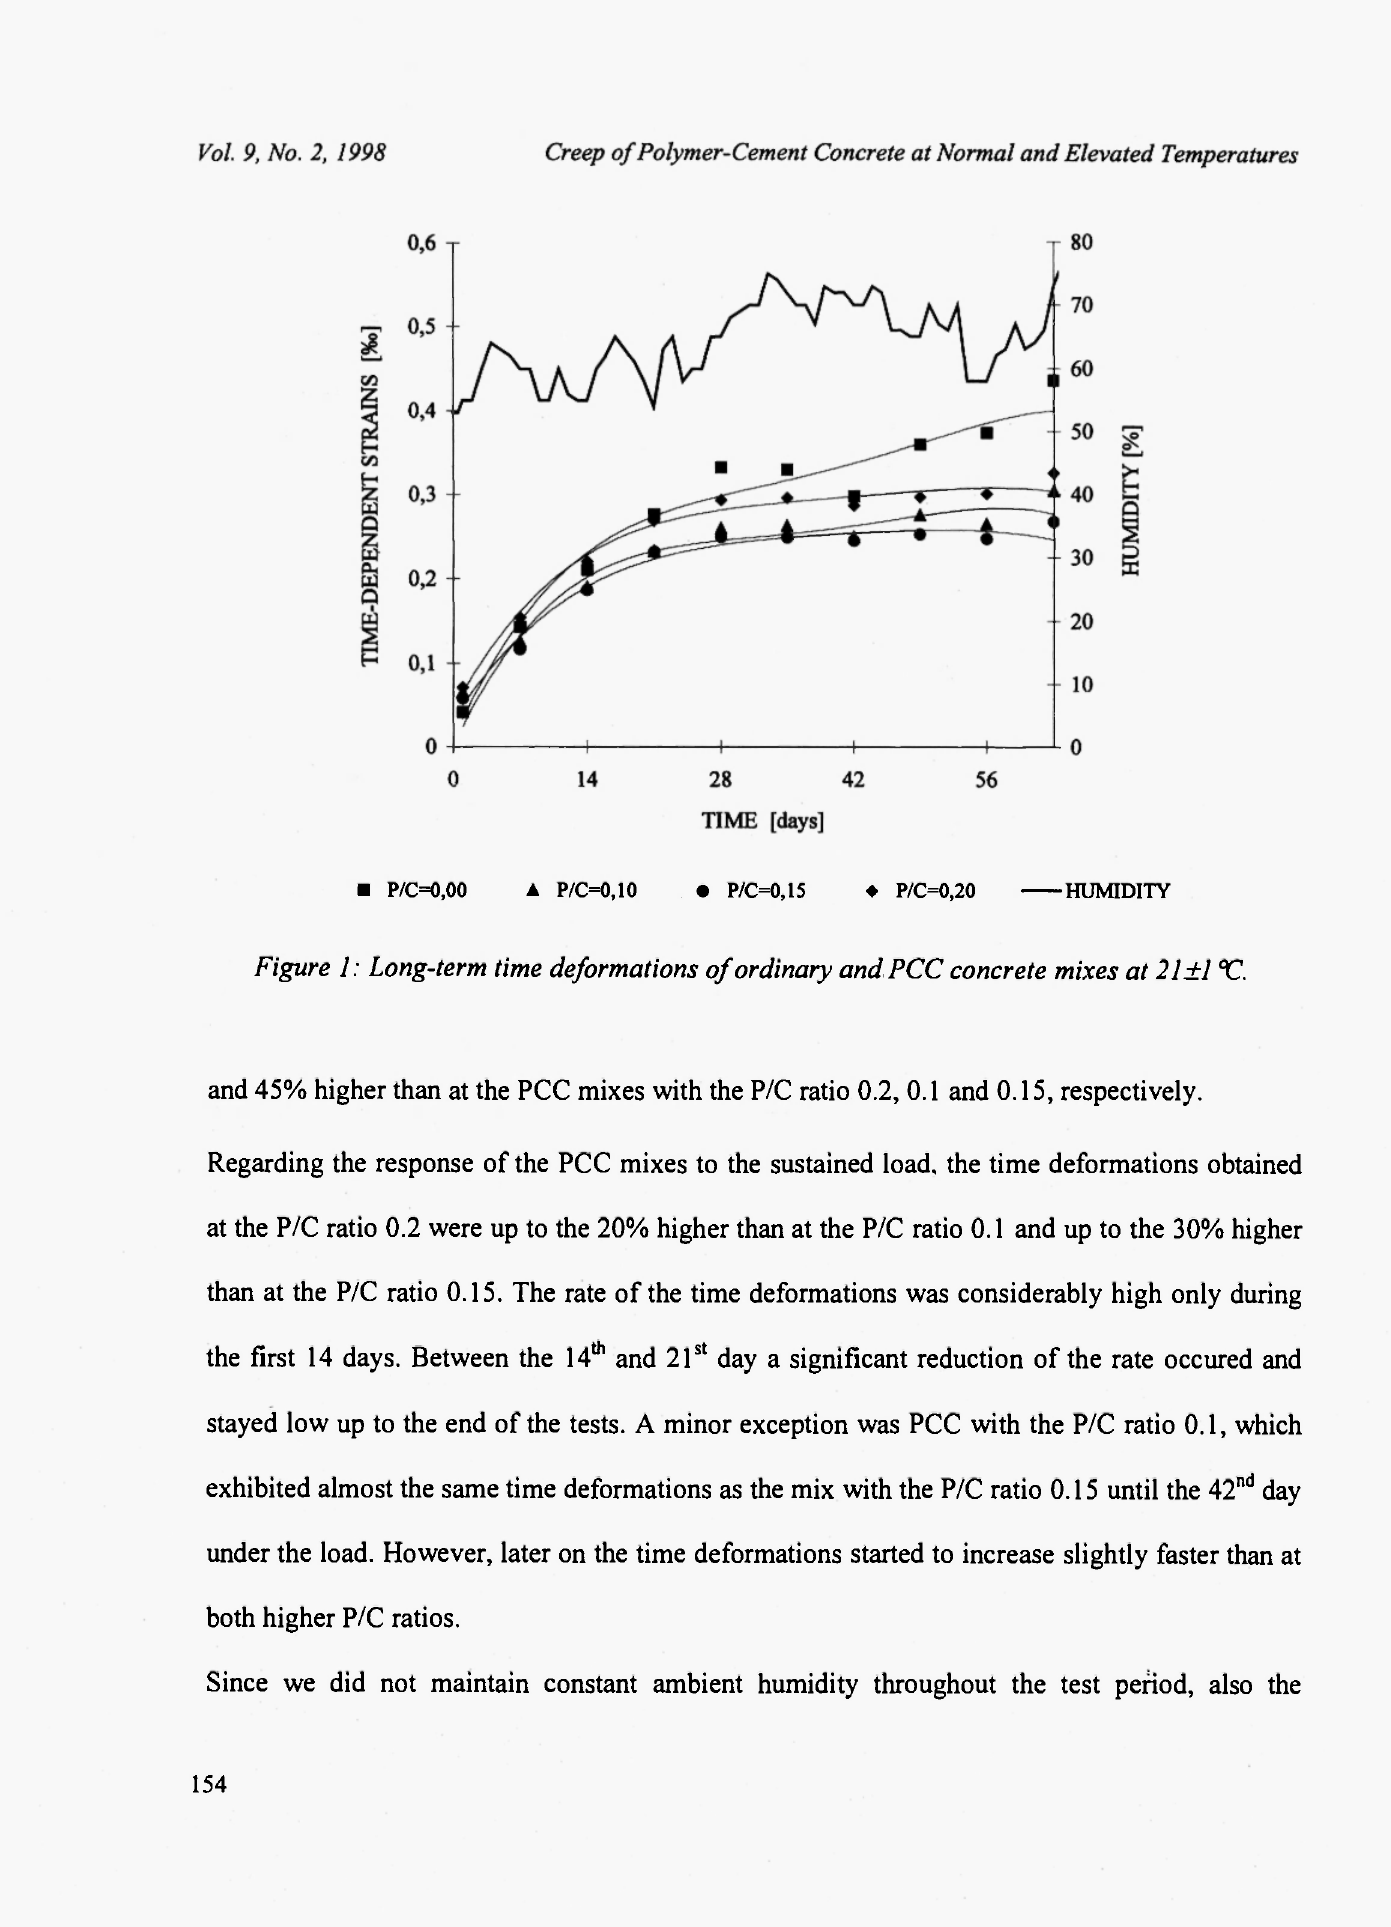
Figure 1: Long-term time deformations of ordinary and Ρ CC concrete mixes at 21±1 °C.